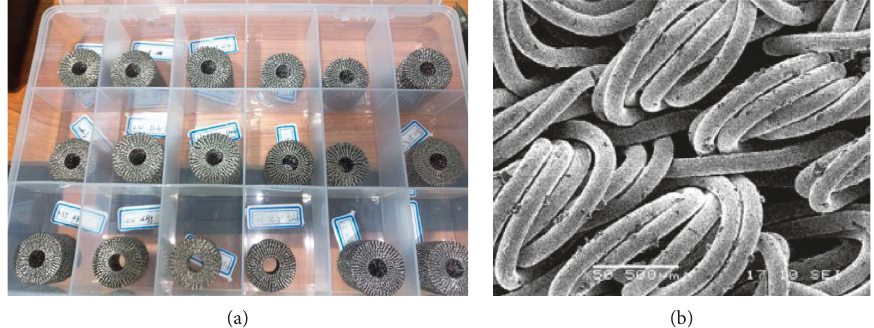
Figure 1: The sample (a) and microstructure (b) of the MR under electron microscope.